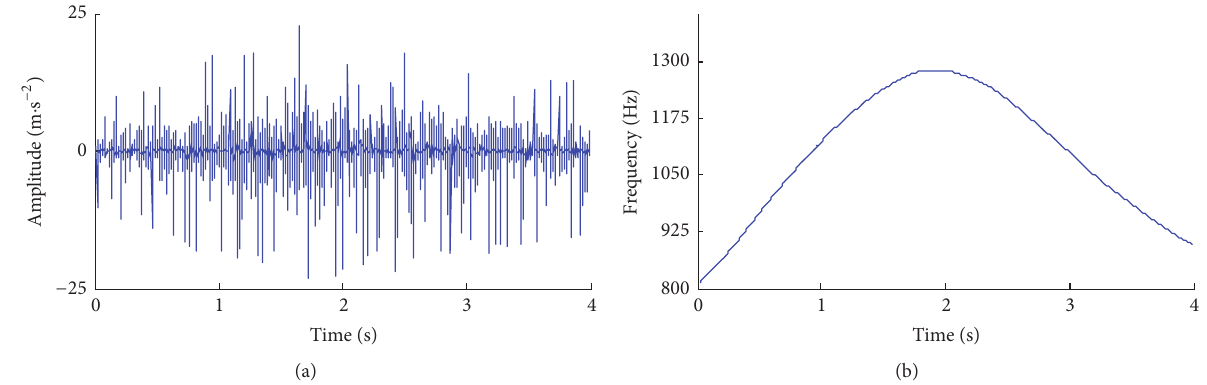
Figure 18: The vibration acceleration signal and the corresponding rotation speed signal of the outer race bearing. (a) The acceleration signal; (b) the rotation speed signal.